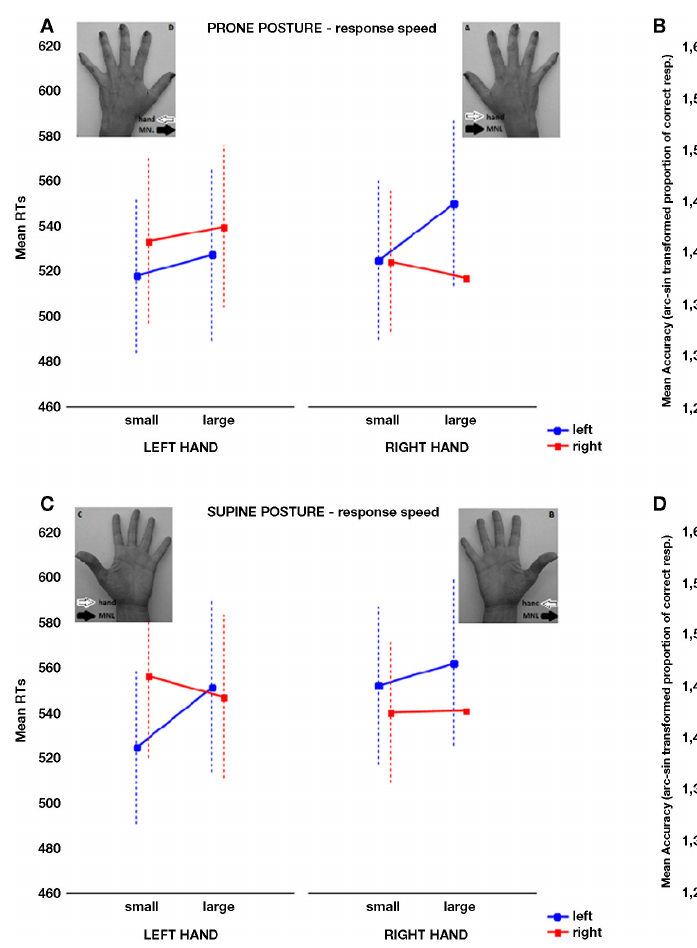
FIGURE 4 |The four-way interaction between posture, responding hand, magnitude, and response key on mean RTs is depicted. Vertical bars denote 95% confidence intervals. (A,B) When participants kept their hands in a prone posture, the SNARC effect was significant for the right hand only (and